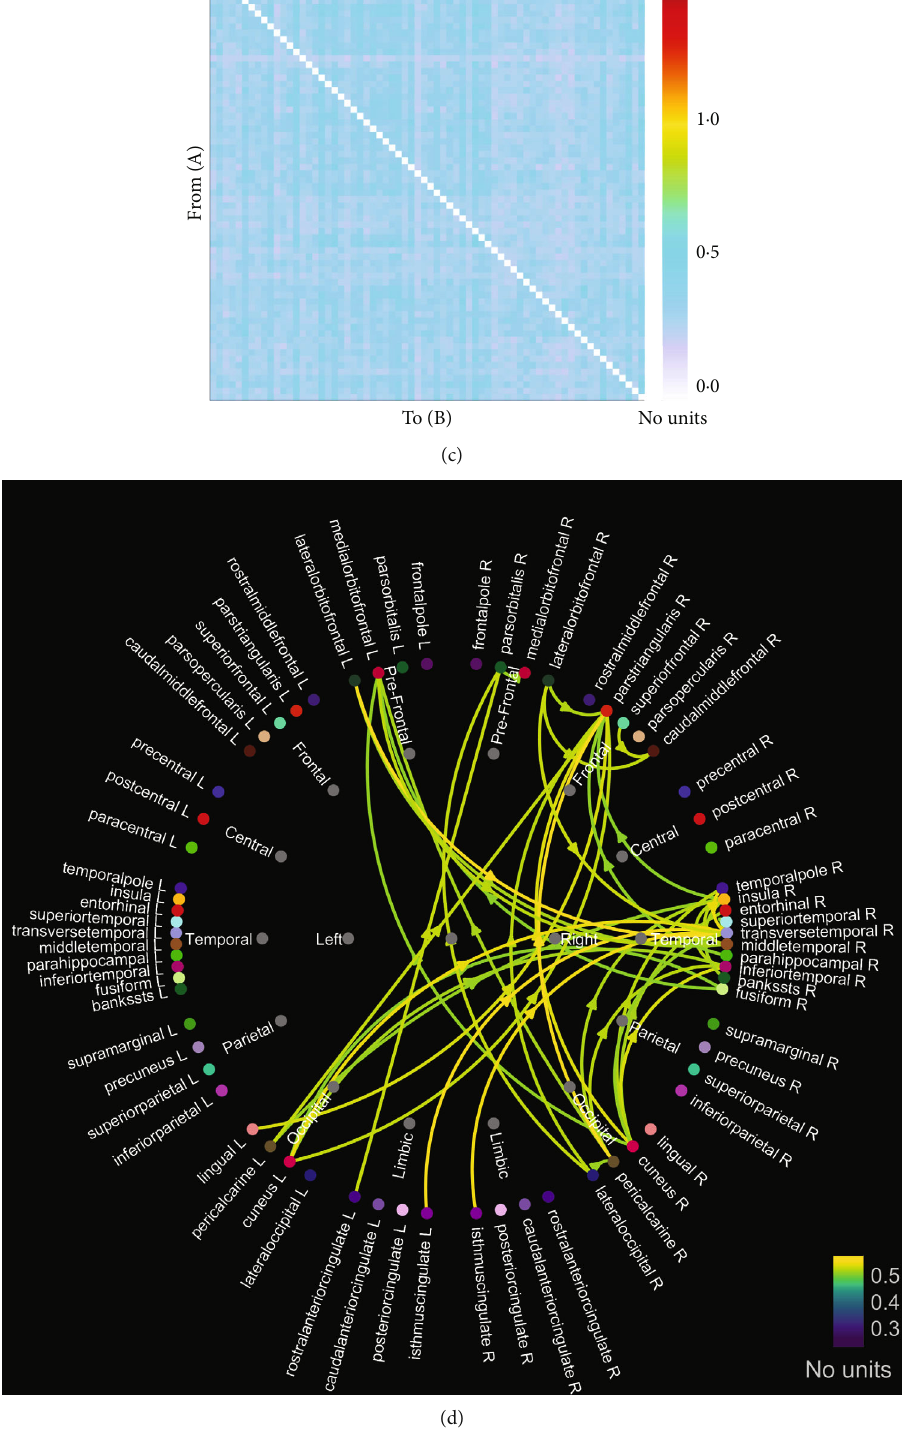
Figure 7: Granger ’ s causality matrix diagram and circos diagram. (a, b) The Granger causality of the CG group, with more directional connections. (c, d) The Granger causality of DOC group. At the same threshold, the intensity of directed connections in the DOC group decreased signi fi cantly, and the number and intensity of directed connections between hemispheres in the DOC group decreased compared with that in the CG group. (DOC: disorder of consciousness; CG: control